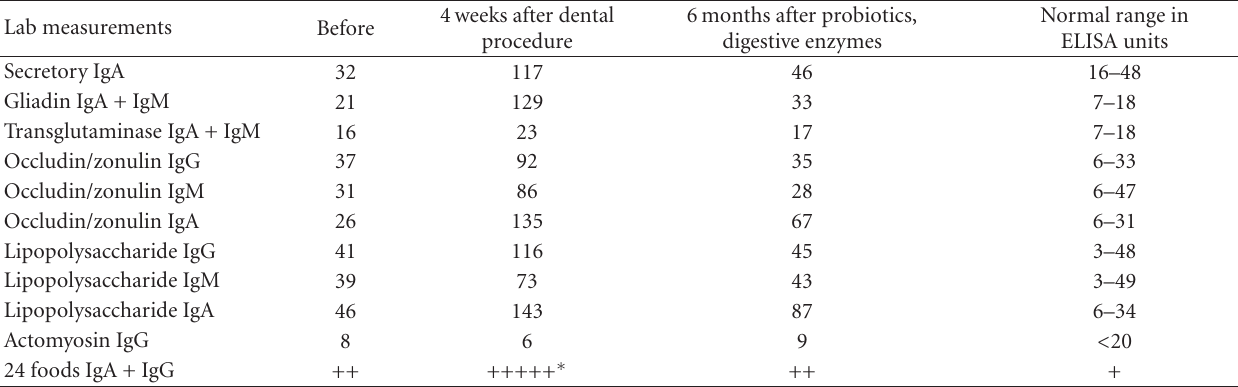
Table 2: Pre- and postoperative results for mucosal immunity, intestinal permeability, and food sensitivity as expressed in ELISA units. Lab